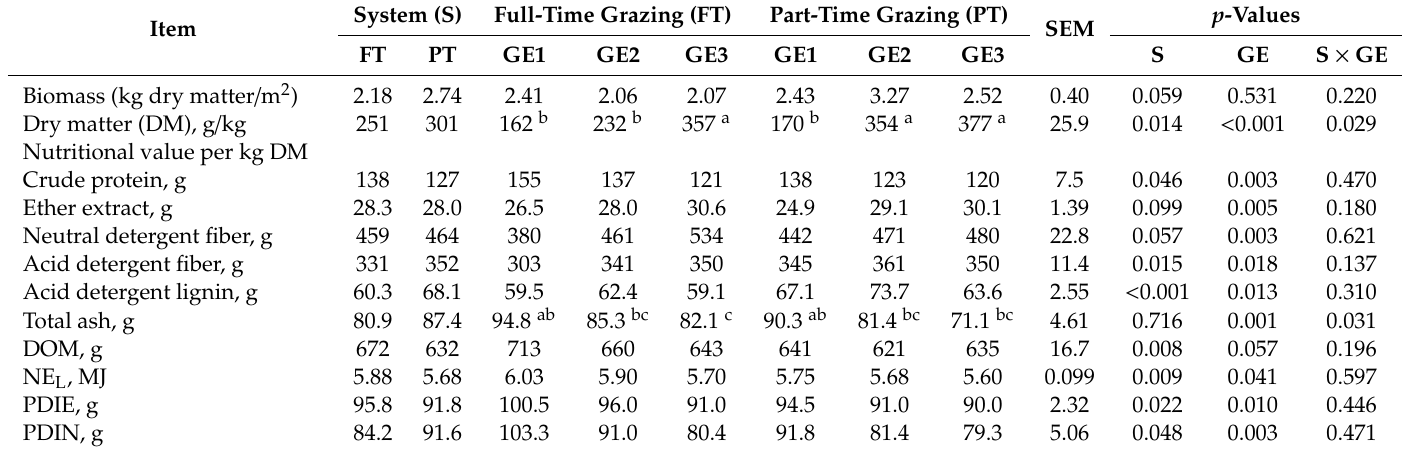
Table 1. Least square means of herbage biomass and nutrient composition in the two pasture management systems and the three GEs. System (S) Full-Time Grazing Item